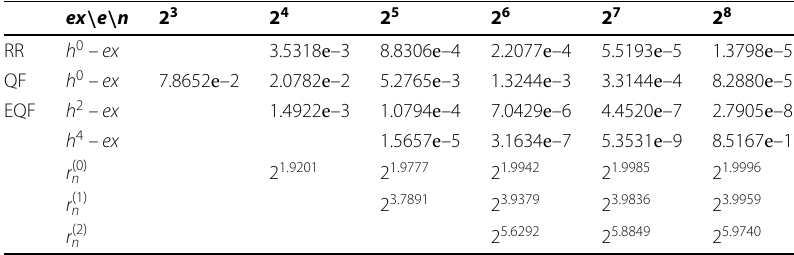
Table 5 The numerical results of QF, EQF, and RR with t =